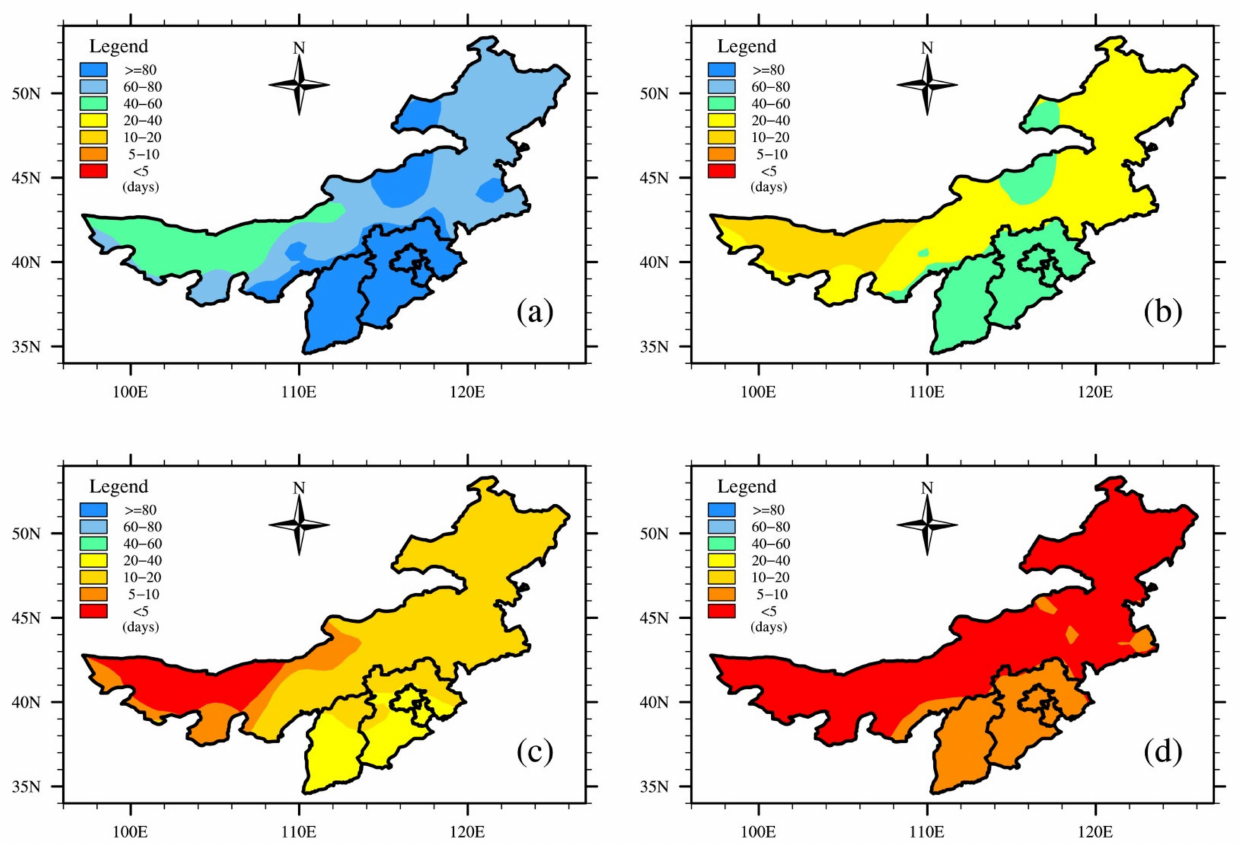
Figure 4. Spatial distribution of the days of mild drought ( a ), moderate drought ( b ), heavy drought ( c ) and extreme drought ( d ) in North China from 1960 to 2019.